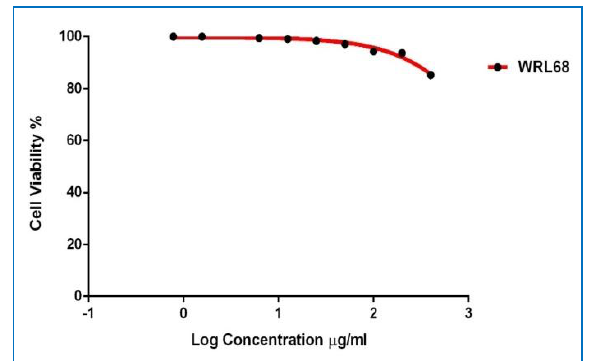
Figure, 2: Agarose gel electrophoresis of PCR amplified products from extracted Aeromonas hydrophila DNA amplified with primer ahMP .